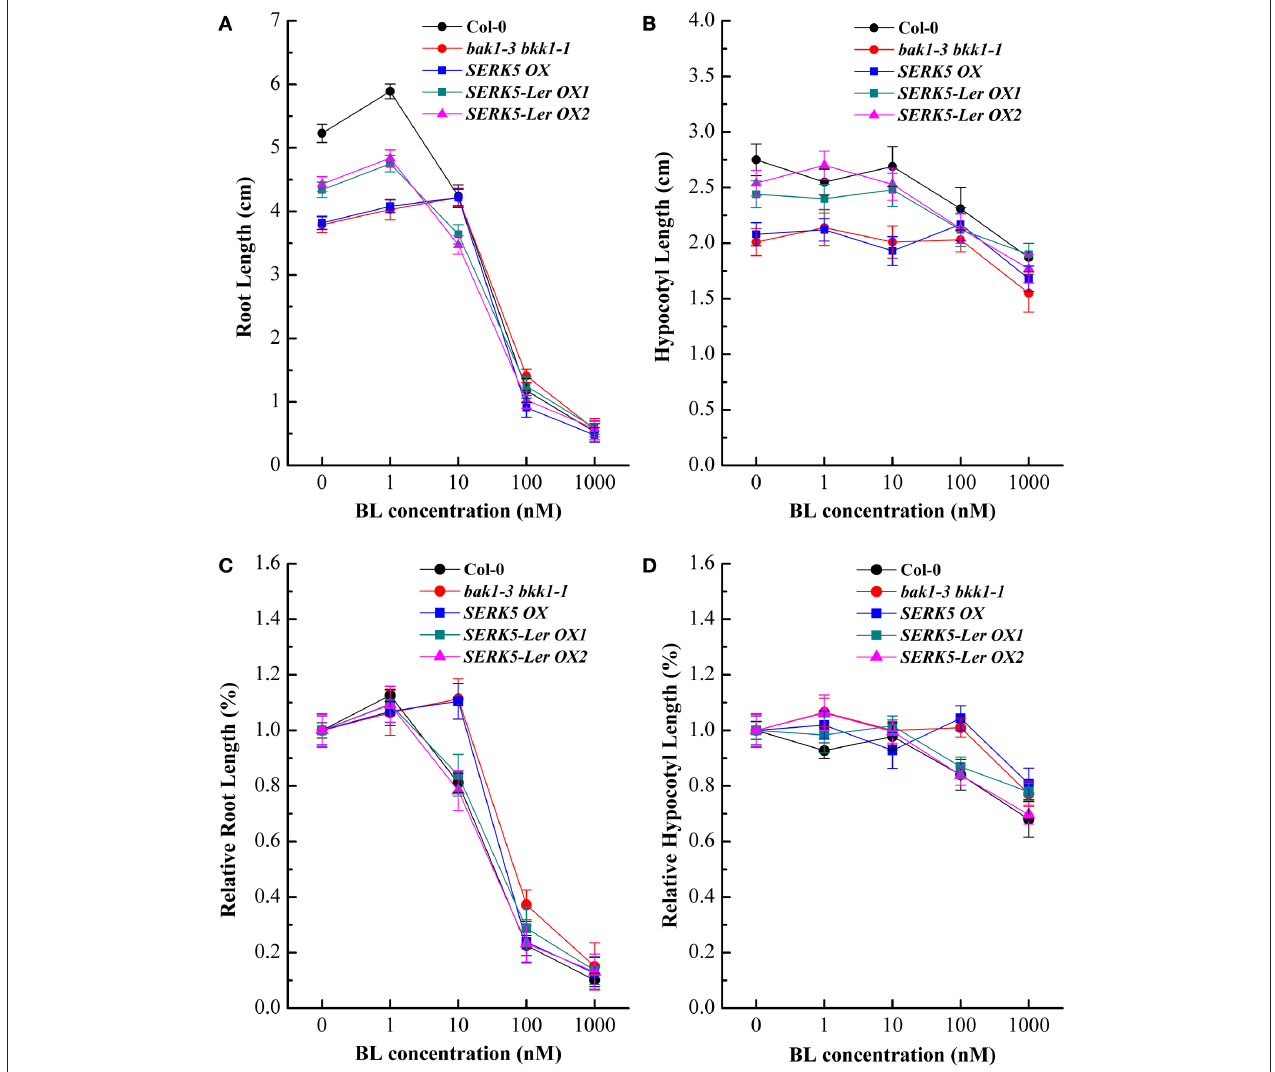
FIGURE 6 | Elevated expression of SERK5 -L er in bak1-3 bkk1-1 restore its sensitivity to BL. The root and hypocotyl growth of 8-day-old seedlings grown on 1/2 MS medium containing different concentrations of 24-epiBL in the light and dark were analyzed. (A) Root lengths of the seedlings under 24-epiBL treatments. (B) Hypocotyl lengths of the seedlings under 24-epiBL treatments. (C) Relative root growth of the seedlings presented in (A) . Overexpression of SERK5 -L er in bak1-3 bkk1-1 restore its sensitivity when treated with 10nM 24-epiBL. (D) Relative hypocotyl growth of the seedlings presented in (C) . Overexpression of SERK5 -L er in bak1-3 bkk1-1 restores its sensitivity when treated with 100nM 24-epiBL. The data are shown as means ± standard deviation (SD) ( n ≧ 40). Experiments were repeated five times with similar results.